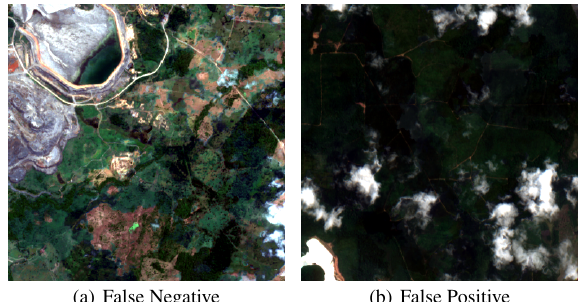
Figure 4. Examples of dam and non-dam samples incorrectly labeled. Images (a) is false negative (dam image predicted as non-dam) and image (b) is a false positive (non-dam image that have been classified as dam)